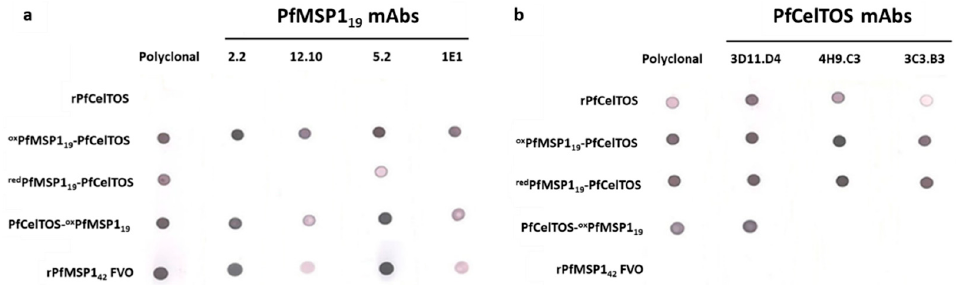
Figure 2. Antigen localization on SAPN influences immunoreactivity. ( a , b ) Reactivity of confor ‐ mation ‐ dependent P. falciparum MSP1 19 ( a ) and P. falciparum CelTOS ( b ) monoclonal antibodies to the